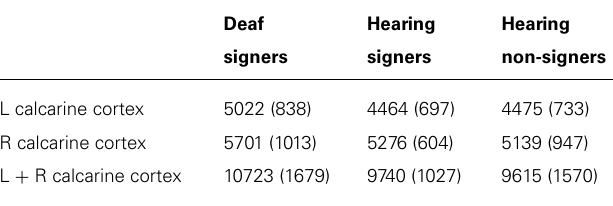
Table 1 | Cortical volumes of the left, right, and total (L + R) calcarine cortex.